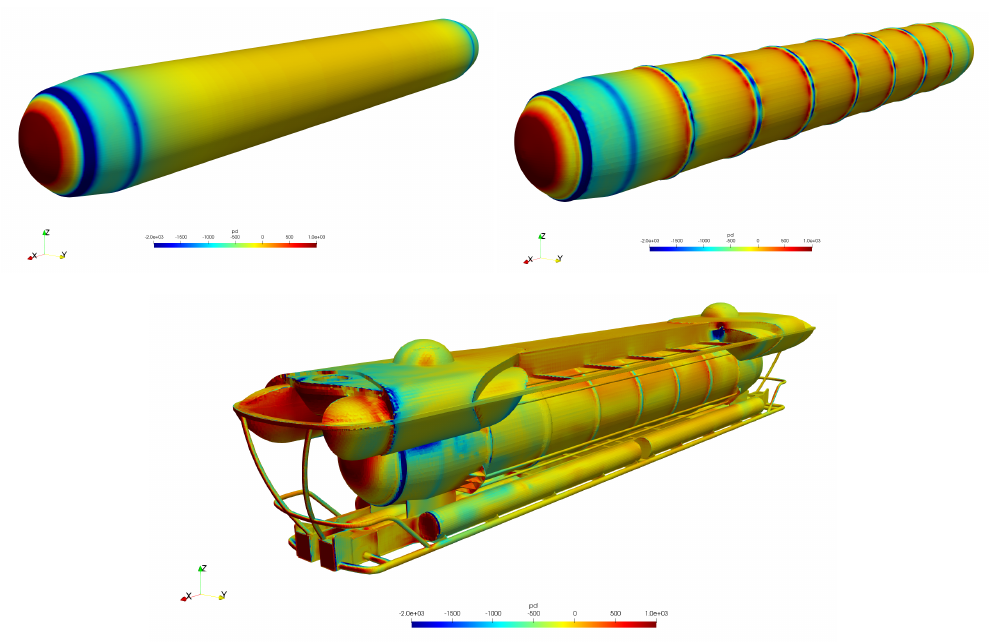
Figure 16. Pressure distribution for Geometry 1, 2, and 3, from left to bottom right. Pressure is shown at 4.5 knots for Geometry 1 and 2, and at 3.0 knots for Geometry